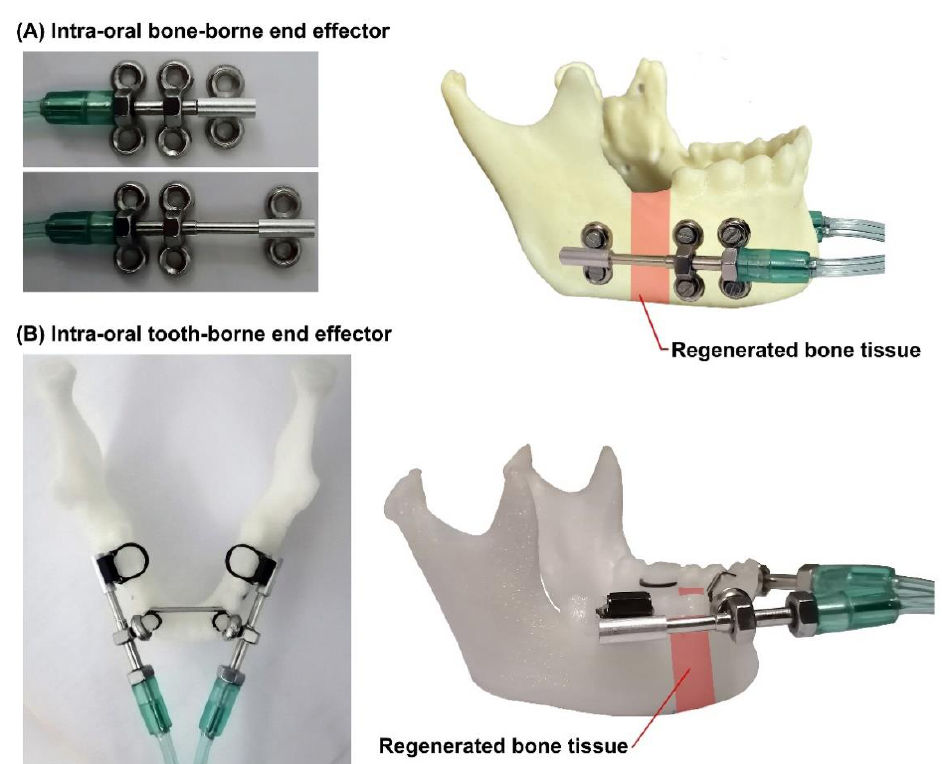
Figure 13. Illustration of the application of two-axis continuous distractor in MRAs using mandible models: ( A ) intra-oral BB end effectors; ( B ) intra-oral TB end effectors.